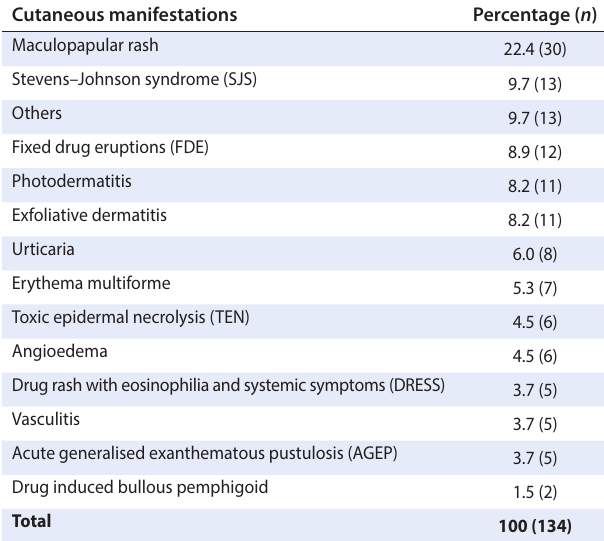
Table 3: Manifestations of ACDR